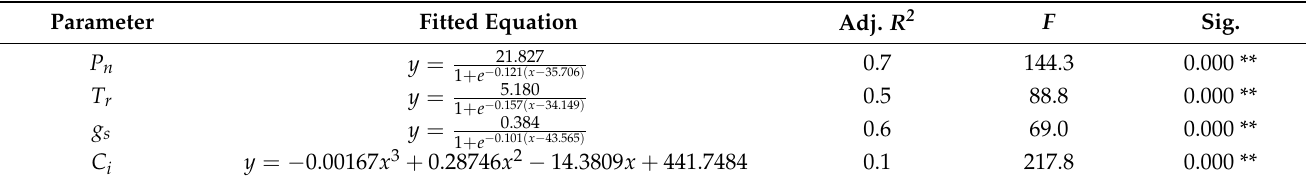
Figure 4. Dynamics in photosynthetic physiological parameters of spring wheat leaves under different relative soil moisture: ( a ) P n parameter, ( b ) T r parameter, ( c ) g s parameter, and ( d ) C i parameter. CK refers to the control group. WS refers to the continuous drought group. The grey dashed line is the reference line of 50% relative soil moisture. Table 2. Curve fitting of photosynthetic physiological parameters of spring wheat leaves under Table 1. One-way ANOVA of photosynthetic physiological parameters of spring wheat leaves rapid-drought under different soil water treatments.